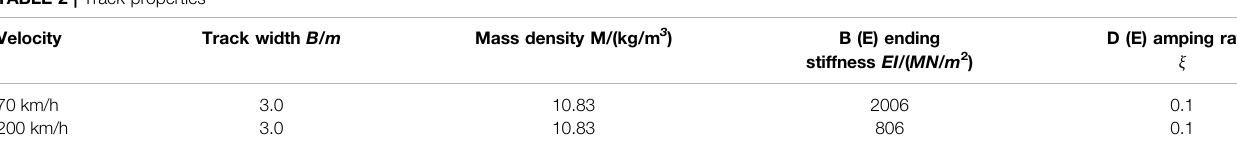
TABLE 2 | Track properties